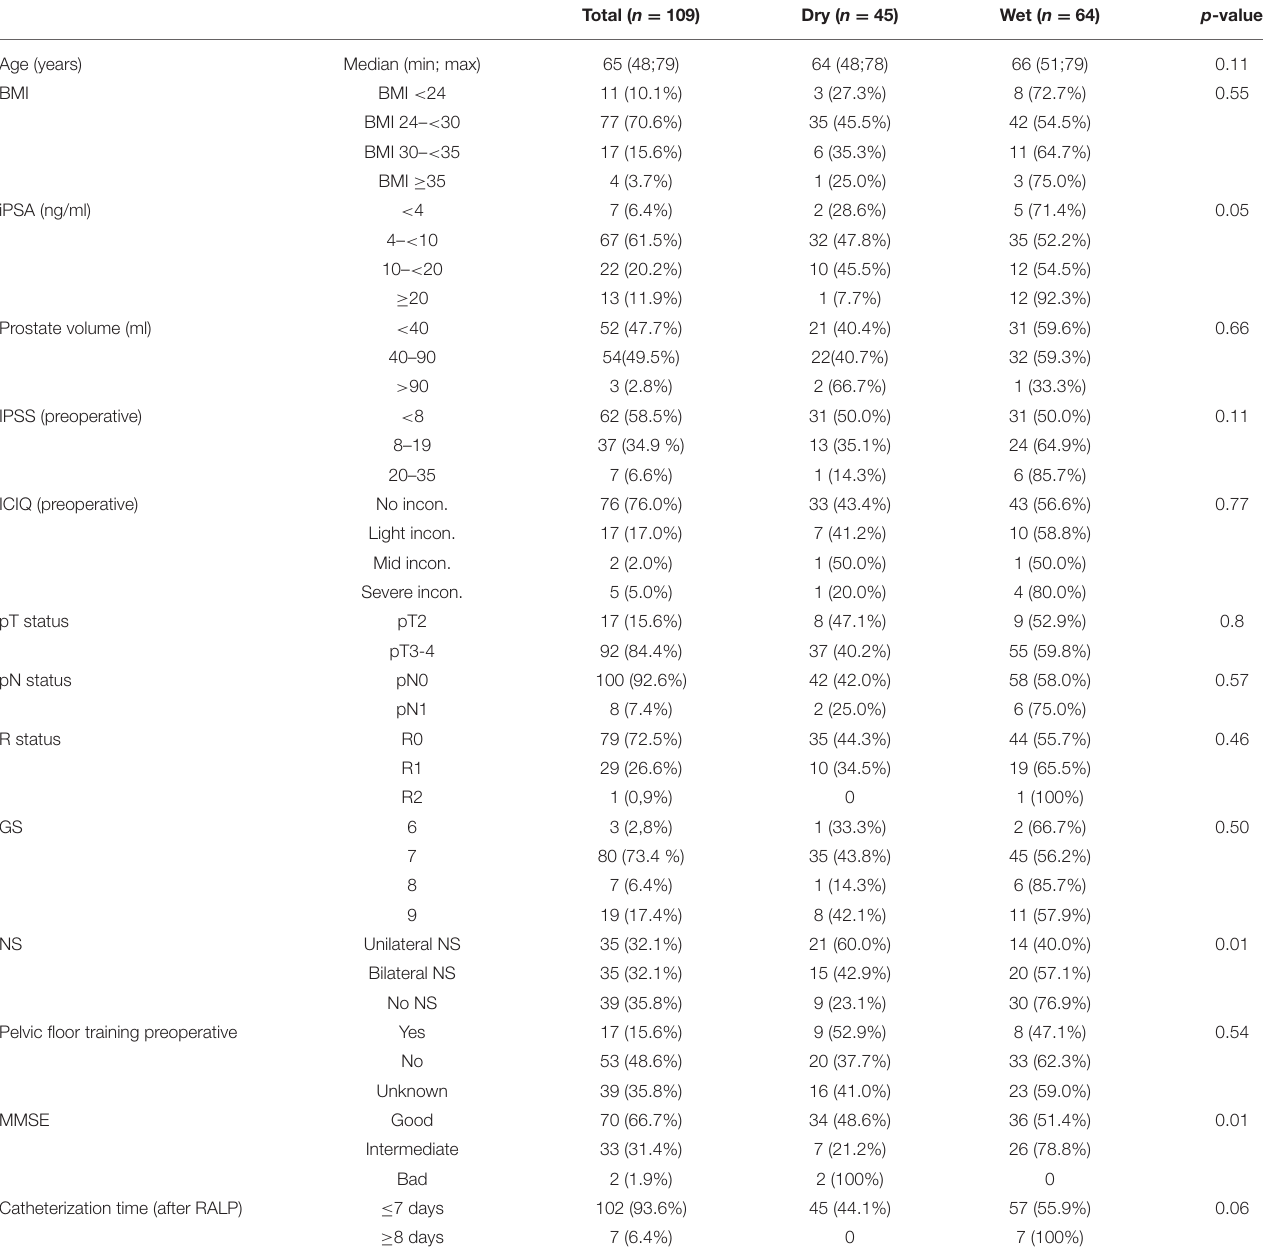
TABLE 1 | Patient characteristics between the “dry” and the “wet”